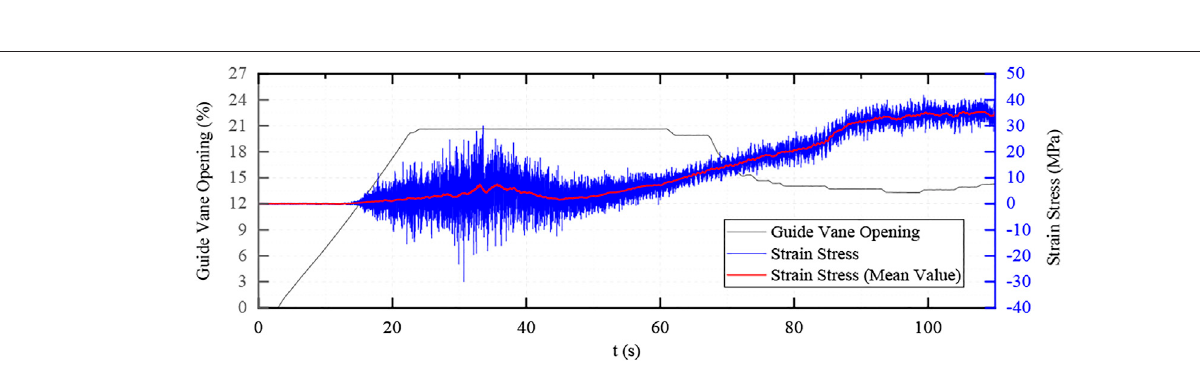
FIGURE 9 | The stress curve of the blade back in the direction of vertical water fl ow (single stage acceleration).